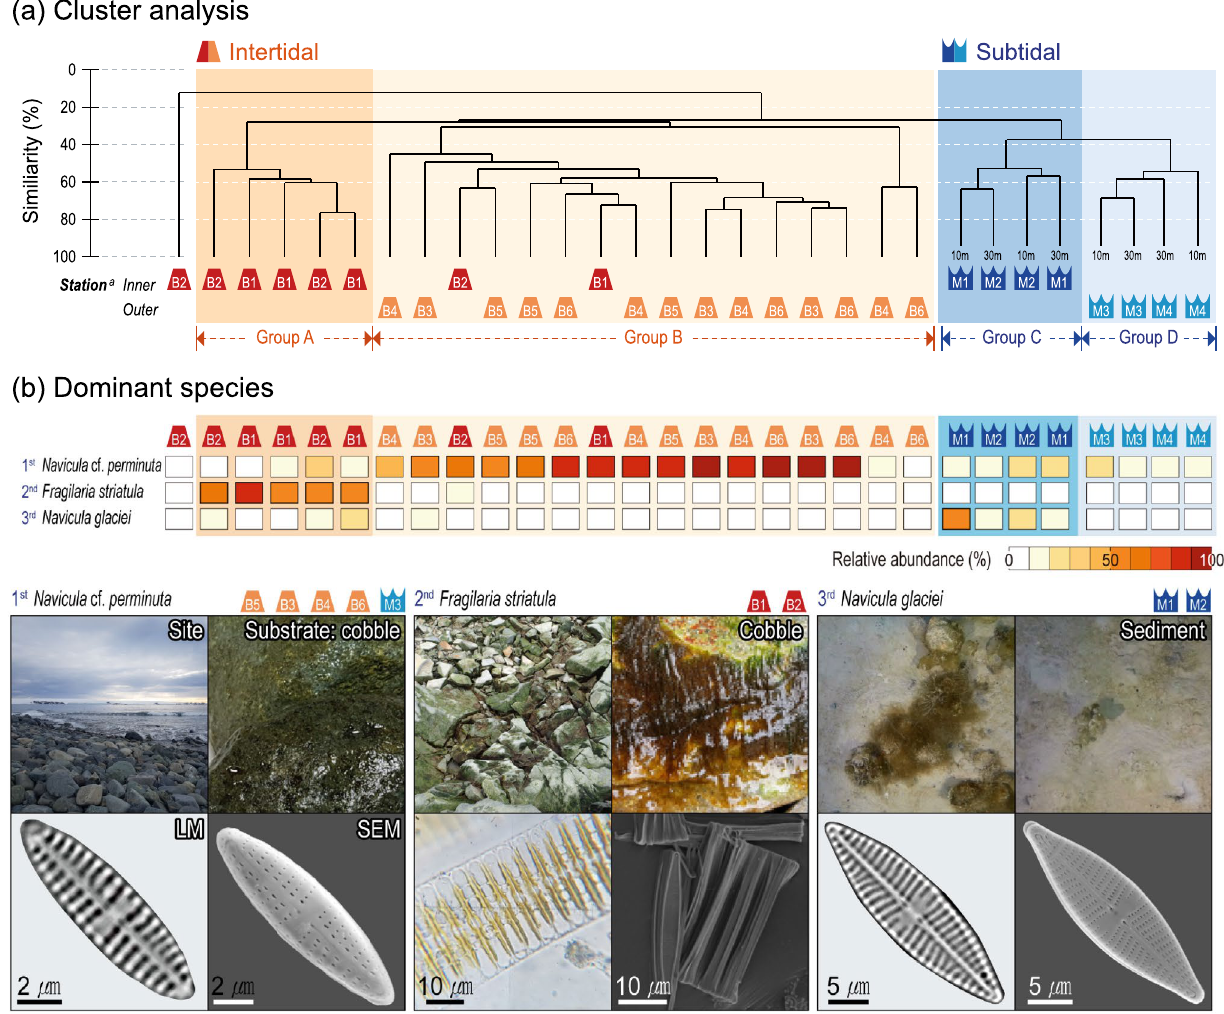
Figure 2. Community structure of benthic diatoms in Marian Cove, West Antarctica; ( a ) cluster analysis results showing the four groups of diatom assemblages ( a Sampling details given in Fig. S1). ( b ) Relative abundance of the top three dominant species in the corresponding locations with site/substrate view and LM and SEM Out of the 49 diatom taxa identified in the intertidal zone, Navicula cf. perminuta (53.5%) and Fragilaria striatula (14.4%) were the two predominant species. In comparison, chain-forming diatoms, such as F. striatula , F. cf. striatula , and Fragilaria islandica var. adeliae , dominated (48.0%) the inner intertidal locations (B1–B2). Subtidal benthic diatoms included 82 taxa, which exhibited higher diversity compared to intertidal ben- thic diatoms, despite substrate type being limited to muddy bottoms. Dominant species were N. cf. perminuta (16.7%) and Navicula glaciei (15.9%). Of note, N. cf. perminuta appeared across all locations in Marian Cove. In comparison, the diatom, N. glaciei , dominated M1 and M2 (76.7% and 37.0%, respectively), and did not occur in the outer locations (M3–M4). Distribution characteristics of benthic diatoms. Four benthic diatom groups were identified by cluster analysis (ANOSIM: R = 0.83, p < 0.01), and were separated in respect to: (1) water depth (intertidal and subtidal zones), (2) distance from the glacier, and (3) habitat substrate (Figs. 2, 3, Fig. S9). For intertidal diatoms, inner and outer assemblages were separated as Group A and B, respectively. Two locations (B1–B2) in Group A belonged to the glacier retreat zone (< 1.5 km, ice-free area due to glacier retreat since the 1990s). The domi- nance of chain-forming diatom, F. striatula , was characteristic of Group A. Group B mainly encompassed outer intertidal locations (B3–B6), dominated by diatoms attached to limpet shells. The indicator species of Group B was N. cf. perminuta (69.2%), which is a commonly occurring species in Marian Cove (Fig. 2b). SIMPER analy- sis (cut-off 70%) confirmed that N . cf. perminuta contributed most to the Group B assemblage. Of note, each of the five predominant species from the intertidal and subtidal zones showed positive or negative correlations to distance from the glacier (Fig. 3b). Subtidal diatom assemblages were also separated by geographical location. The genus Navicula , including N. glaciei and N . cf. perminuta , dominated the inner region (M1–M2), and belonged to Group C. Cocconeis cf.